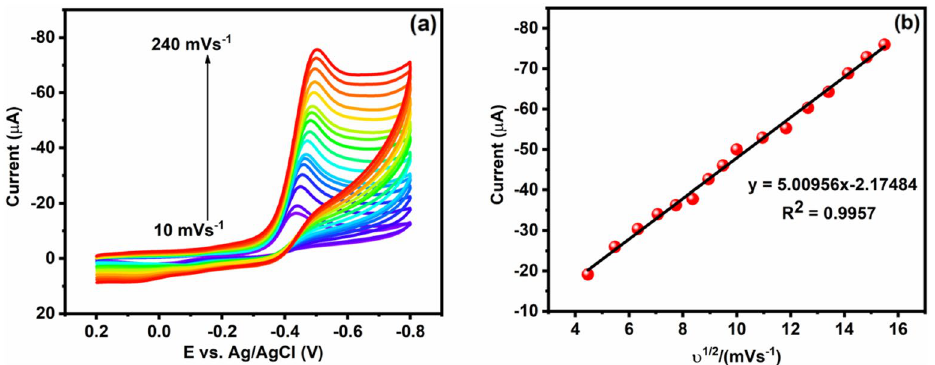
Figure 9. ( a ) Cu/Ni/TiO 2 /MWCNTs nanocomposites with different scan rates of CV curves presence of 0.05 M PBS with 20 μM of FLT. ( b ) linear regression of peak currents vs square root of the scan